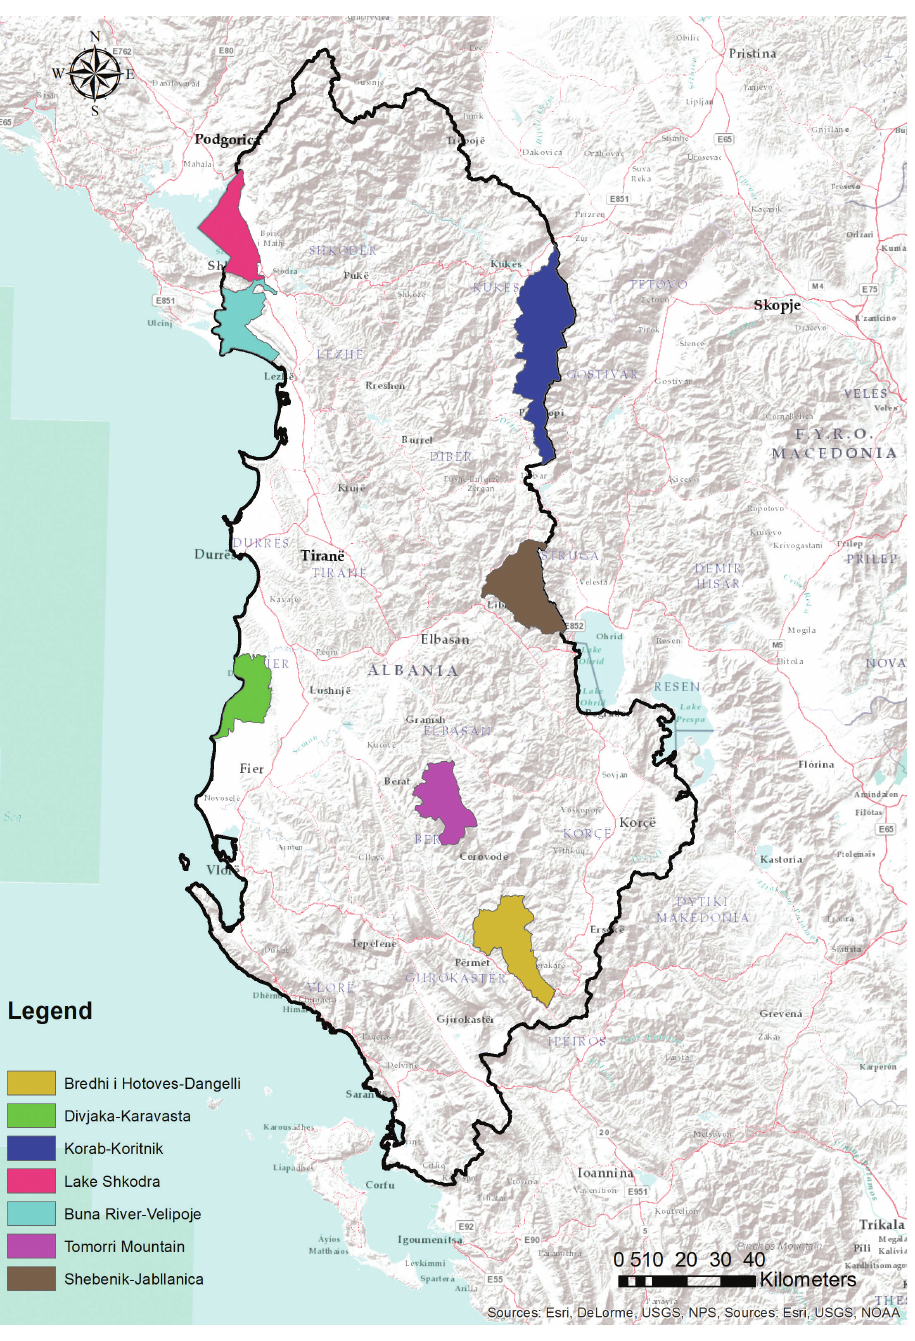
Figure 1. Distribution of the 7 protected areas in which field campaigns have been undertaken dur- ing the “Institutional Support to the Albanian Ministry of Environment, Forest and Water Adminis- tration for Sustainable Biodiversity Conservation and Use in Protected Areas” and NaturAL